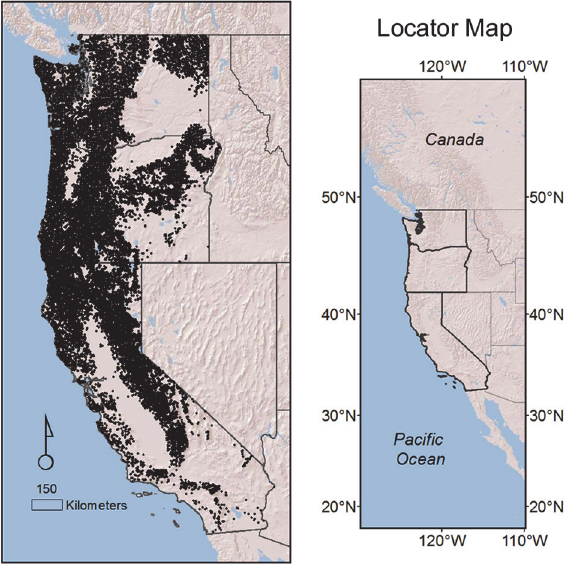
Fig 1. Study area with the location of the 14,105 forested plots. The total area is 823,000 km 2 , 42%